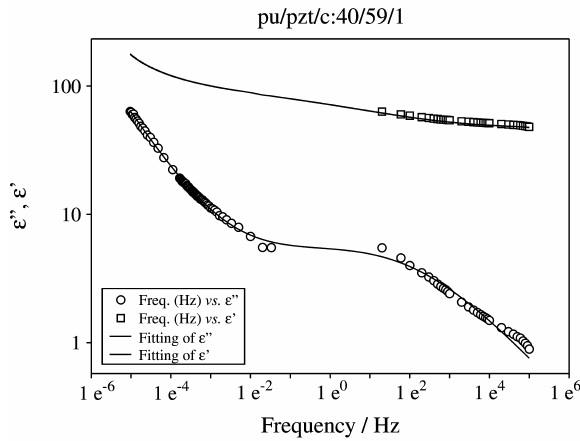
Figure 5. Dielectric behaviour of PZT/PU/C composite. The experimen- tal data were obtained by bridge and time domain